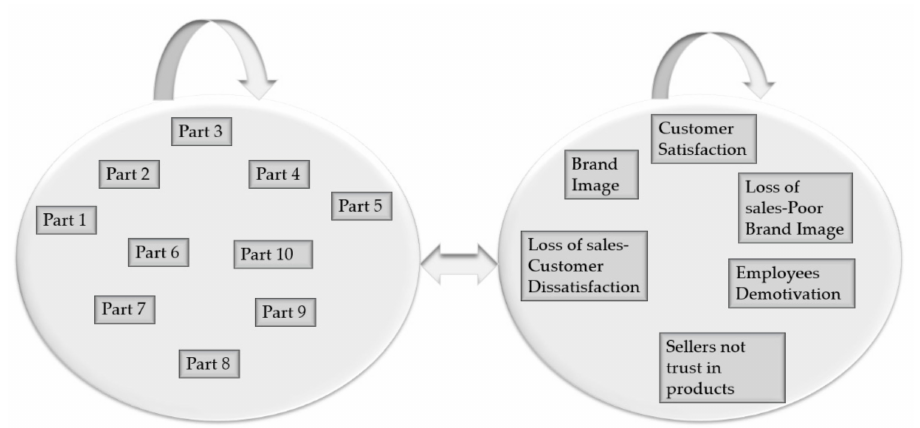
Figure 8. Network structure of